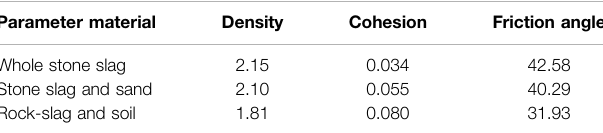
FIGURE 10 | Mohr circle of rock-slag and soil mixture diagram. TABLE.1 | Statistical table of cohesion and friction angle of three kinds of abandoned